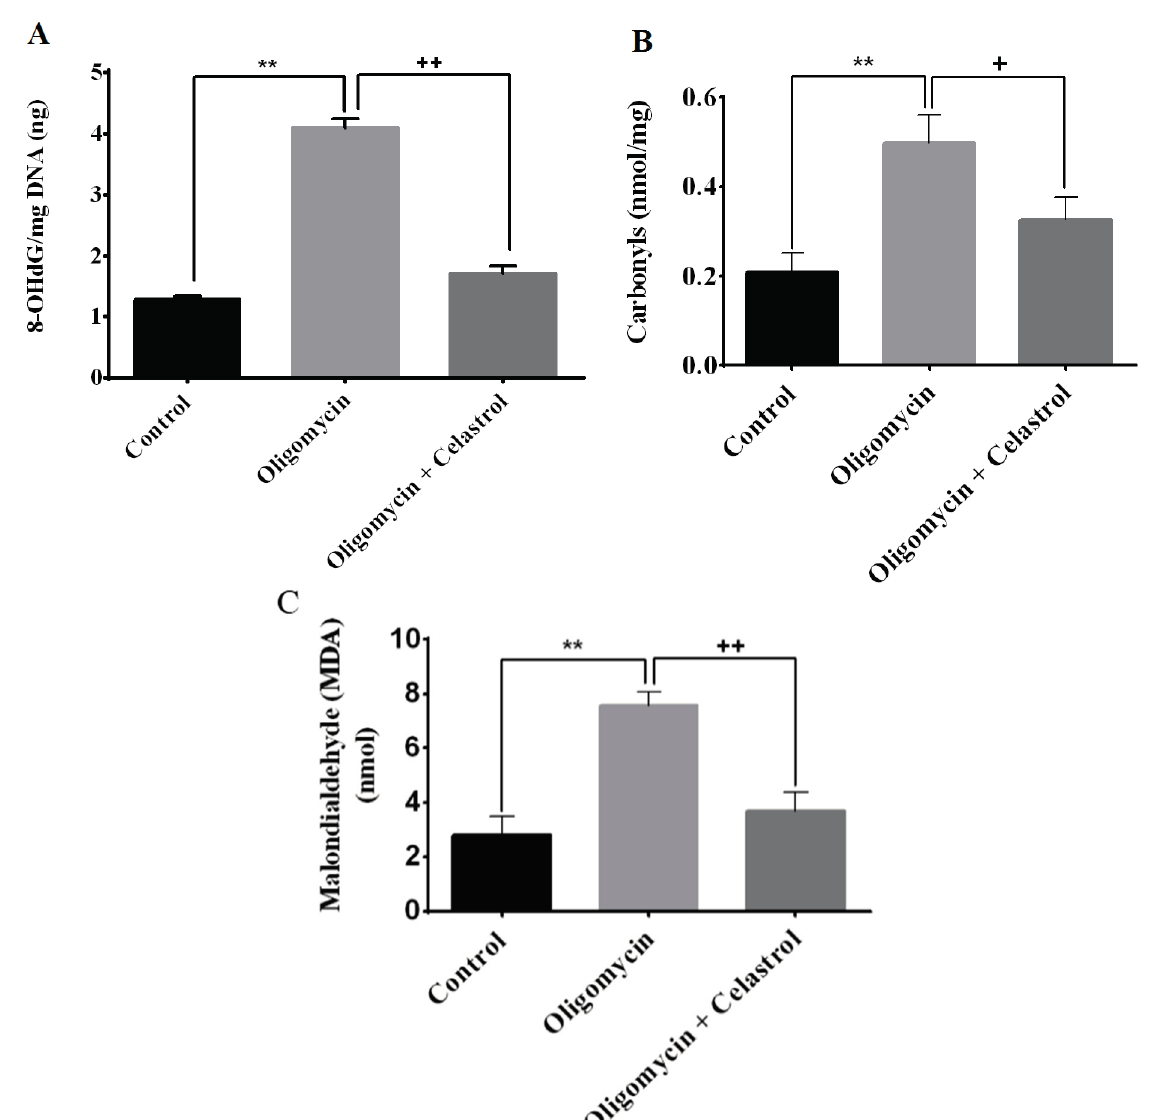
Figure 4. Effects of celastrol treatment on oligomycin-induced oxidative stress in 3T3-L1 adipocytes. Celastrol significantly reduced the oxidative stress of adipocytes with mitochondrial dysfunction. Oxidative profiles of adipocytes were determined via ( A ) measurement of DNA oxidative damage (8-OHdG); ( B ) protein carbonylation and ( C ) lipid peroxidation (MDA). Results are expressed as means ± SEM ( n = 6). ** p < 0.01 vs . untreated control; + p < 0.05 and ++ p < 0.01 vs . oligomycin-treated